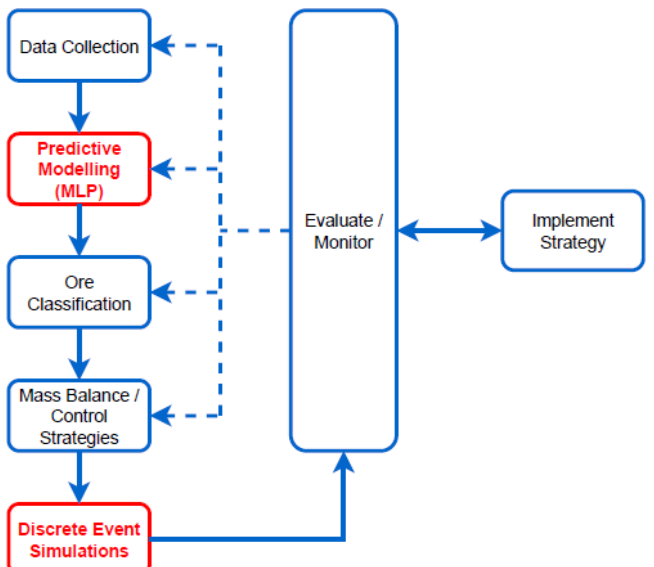
Figure 3. Flow chart showing the architecture and data flows for the developed quantitative frame- work (modified after [40]).